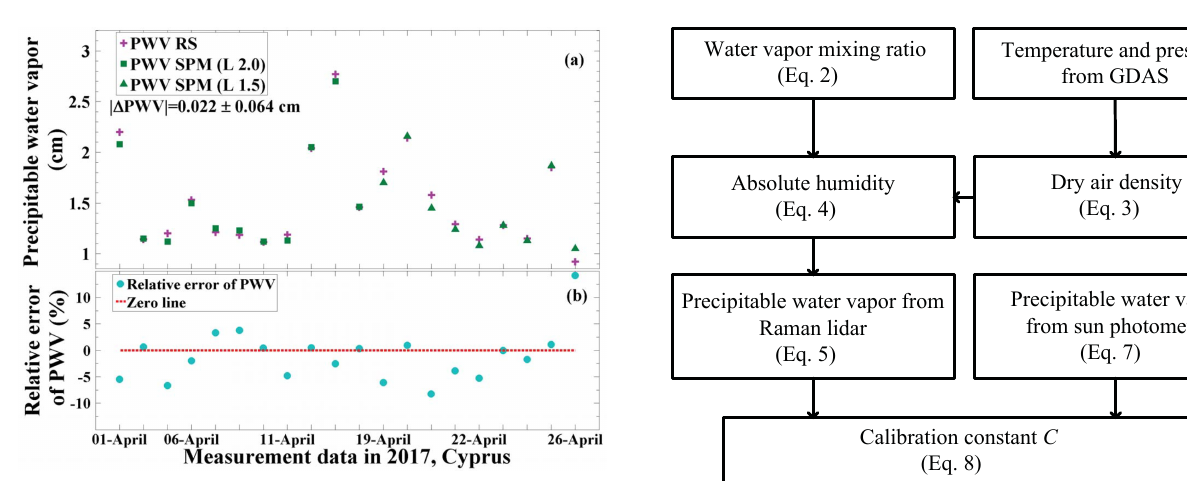
Figure 5. Flowchart of the calibration procedure based on co- located sun photometer observations and GDAS